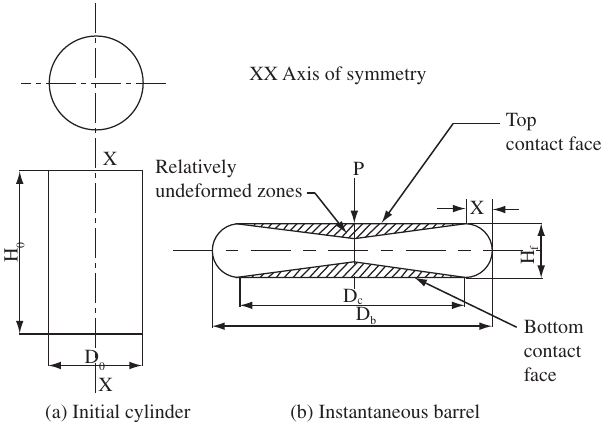
Figure 1. Schematic representation of upset forging test specimen before and after